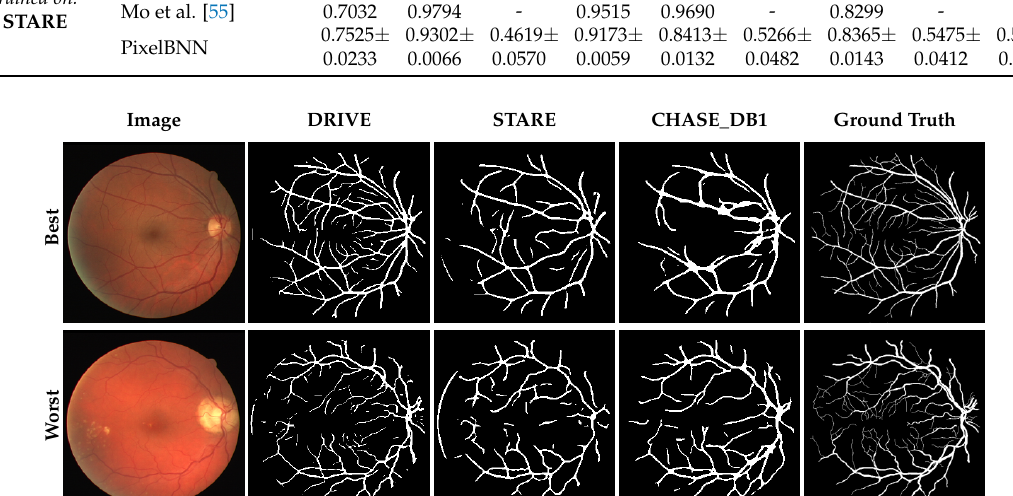
Figure 2. Network predictions on the DRIVE dataset. The top row shows the image, segmentation masks and ground truth for the image that scored best when DRIVE was used to train and test the model; the bottom row shows the worst. For comparison, the cross-validation results from training the model with STARE and CHASE_DB1 are